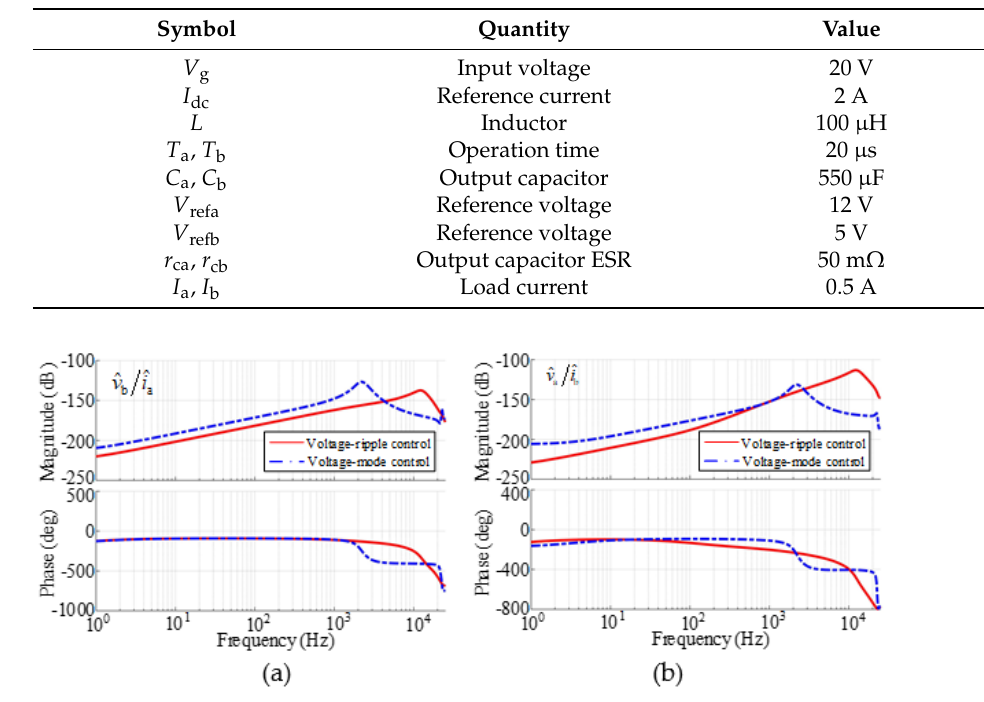
ˆ ˆ v i ; ( b ) ˆ ˆ v i . a a b b